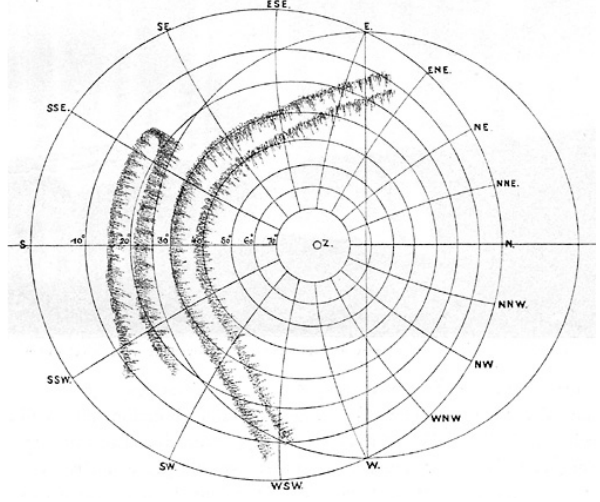
Figure 14. Plot of auroral forms observed on 5 November 1882 at 06h from Godthaab (drawing, Paulsen,